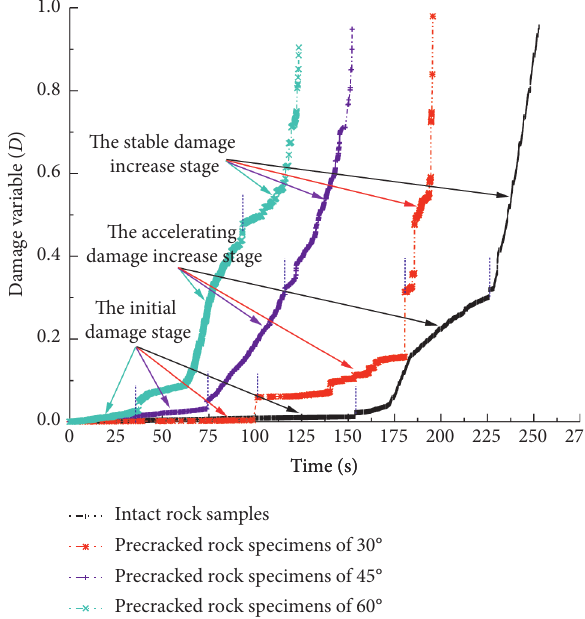
Figure 8: Damage evolution curves of typical intact and precracked rock specimens characterized by the AE